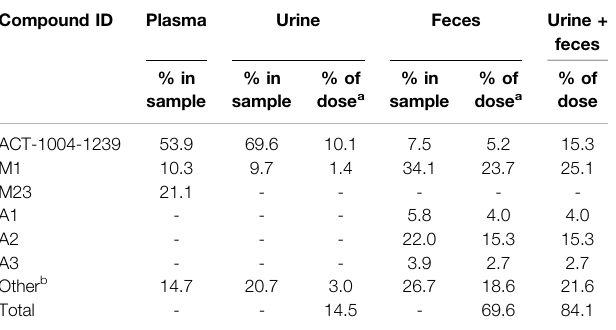
TABLE 2 | Summary of relative abundance of ACT-1004-1239 and its metabolites.